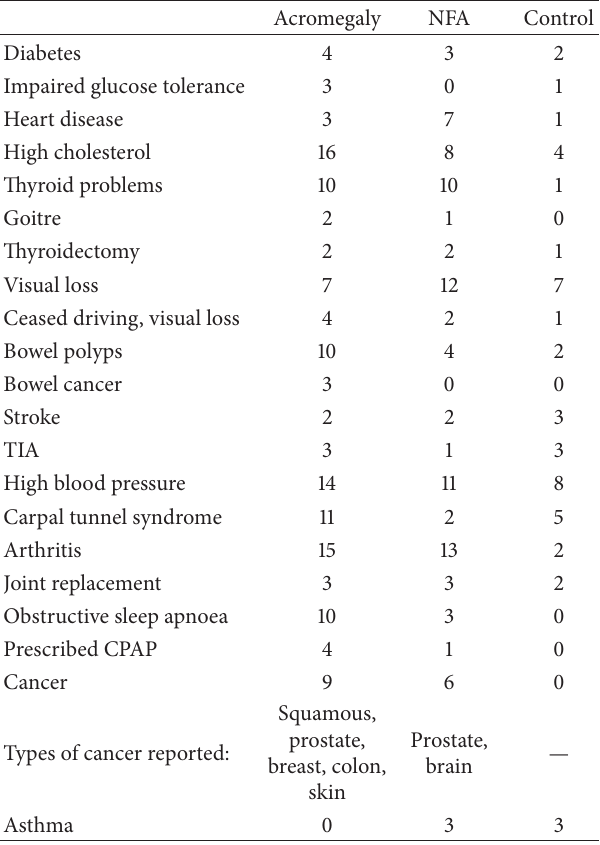
Table 2: Participant